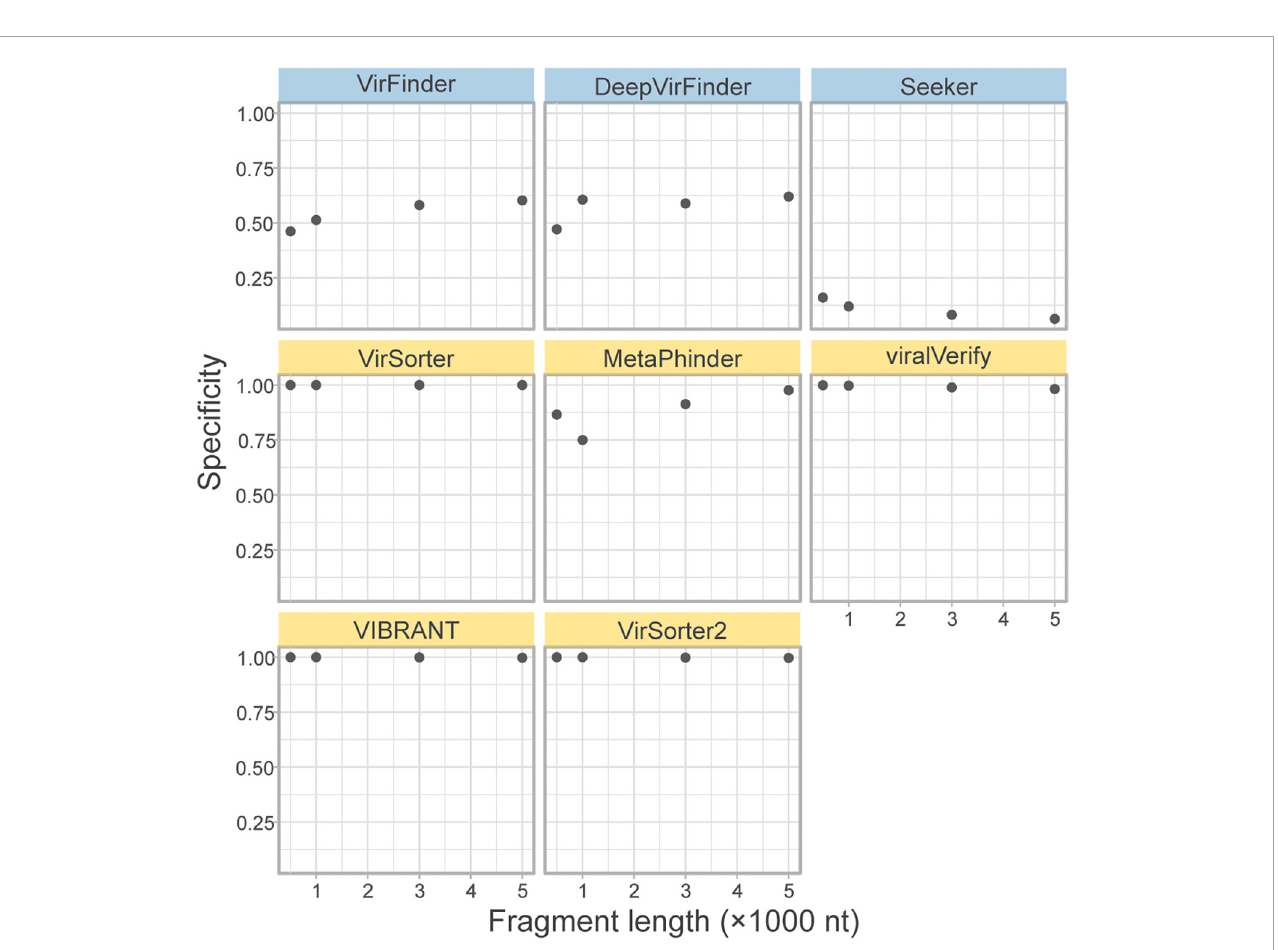
FIGURE5 Classification specificity of eukaryotic genome fragments. Eukaryotic fragments were generated from the Ascomycota and Basidiomycota phyla ( n = 10k) at different length size. The specificity of each tool was measures for each sequence length. Top row of tools are sequence-based (in blue), bottom two rows are homology-based (in